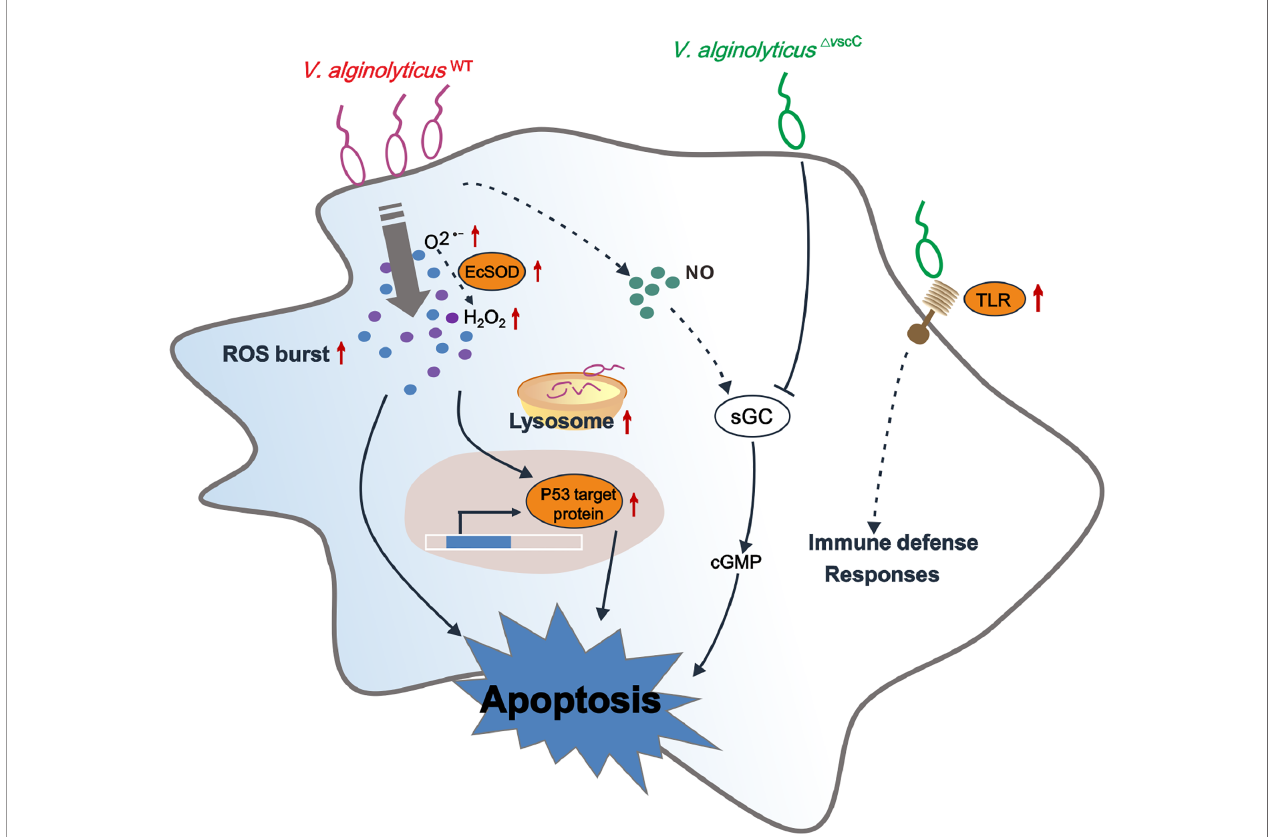
FIGURE 7 | Conceptualization of mechanisms underlying immune defenses in oyster hemocytes during challenge by Vibrio spp. of differential virulence. V. alginolyticus WT challenge gives rise to accumulation of O (cid:129) − 2 and H 2 O 2 , resulting in upregulation of p53 target protein-mediated hemocyte apoptosis, along with an increase in intracellular cGMP. V. alginolyticus △ vscC infection leads to attenuation of cellular defense of the host, along with lower levels of apoptosis. In addition, sGC-cGMP signaling pathway was speci fi cally downregulated during attenuated V. alginolyticus △ vscC strain infection. Interestingly, Toll-like receptor 6 were signi fi cantly upregulated during V. alginolyticus △ vscC infection, which transduce immune signals for further elimination of pathogens through immune effector molecules, such as antimicrobial peptides (AMPs) (87, 88). Solid lines, regulatory mechanisms experimentally veri fi ed in this study; dotted lines, conjectural conclusions from the proteomic